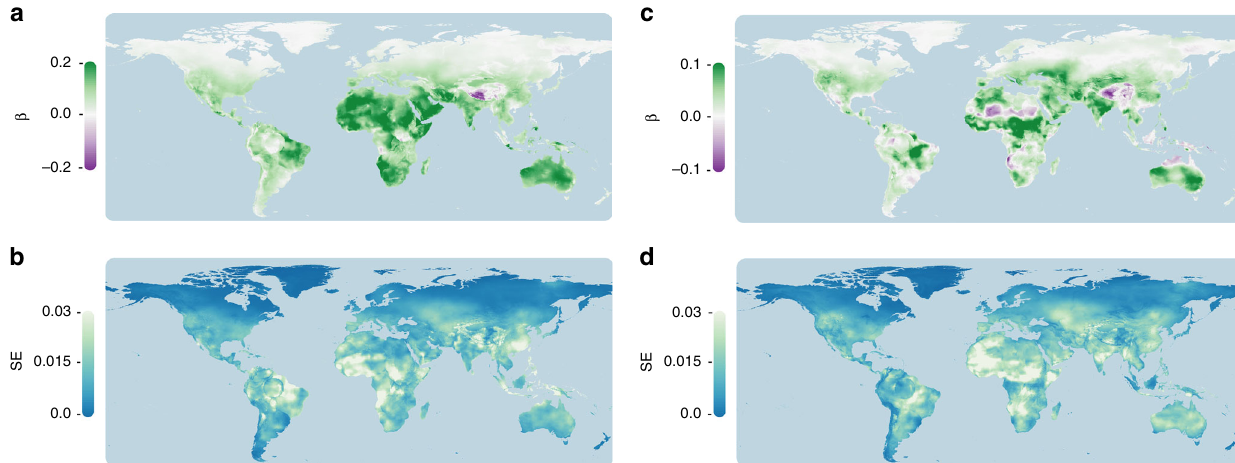
Fig. 2 Global hotspots of temperature as a reliable cue for desiccation risk. a Temperature was generally positively correlated with VPD (as indicated by the slope ( ß )). b The correlations between temperature and VPD is generally strongest between 50° and − 50° latitude (determined using standard error (SE) of the slope), with regions of high correlation in South America, Africa, the Middle East, and Australia. c Temperature was generally positively associated with the variation in VPD. d The standard error of the correlations between temperature and variation in VPD is generally low outside of the tropics but high for areas in Africa and parts of the Amazon and south-central Asia. Figures were generated using custom script in Python (v. 3.6) using data from the TerraClimate database (http://www.climatologylab.org/terraclimate.html) 34